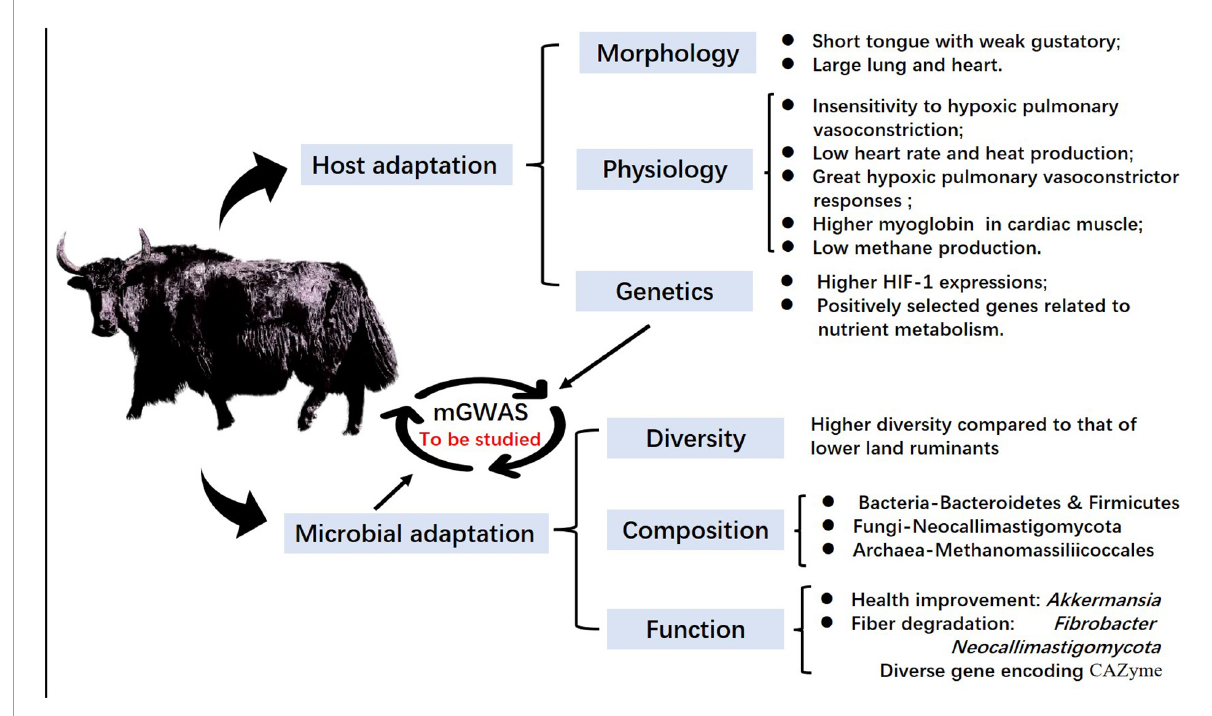
FIGURE2 Yak adaptation to the Qinghai–Tibetan plateau in the view of both host and rumen microbiota.